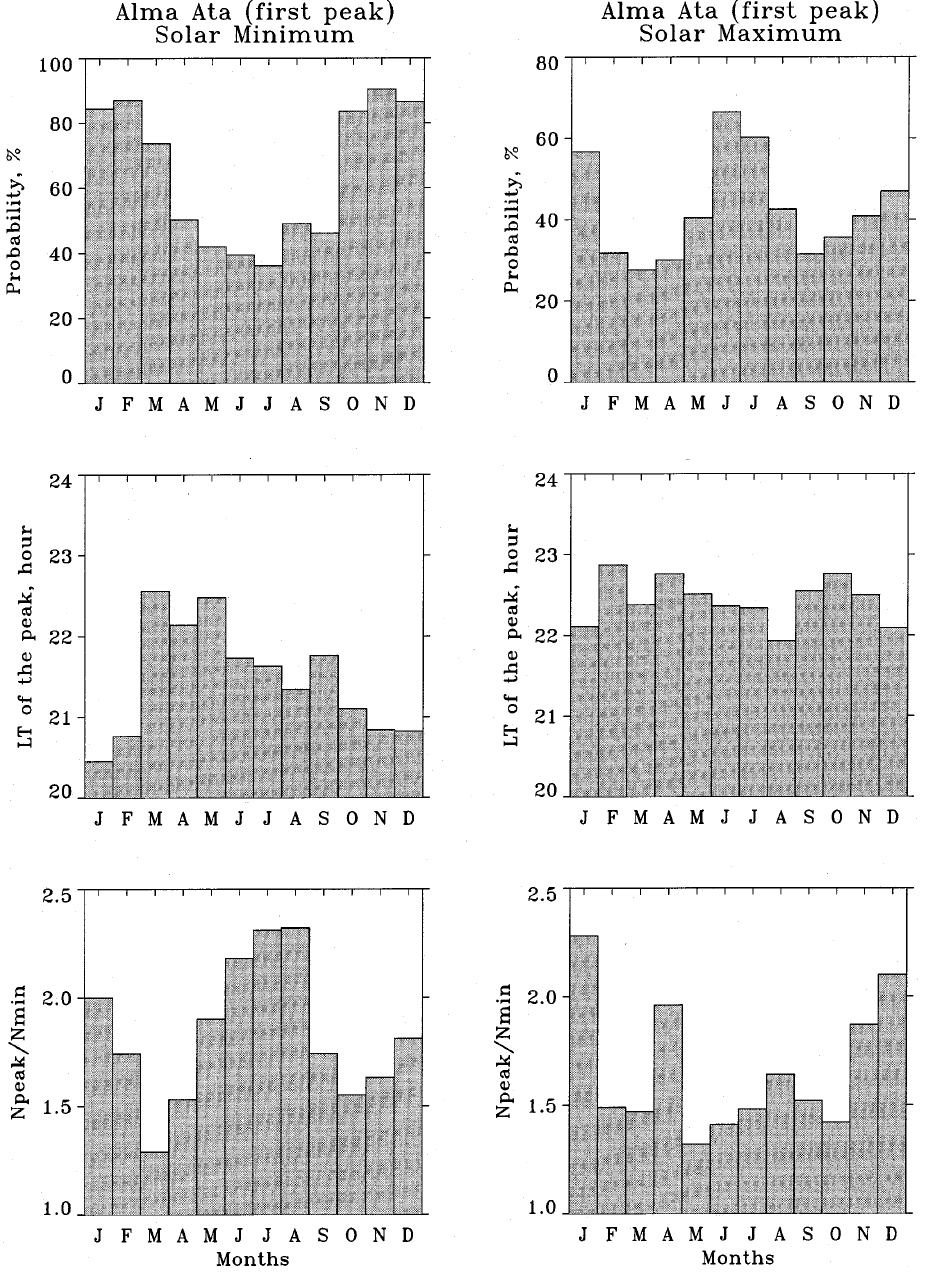
Fig. 2. Seasonal variations of occurrence probability ( top ), timing ( middle ), and amplitude ( bottom ) of the 1st peak at Alma-Ata at solar minimum ( left-hand side ) and solar maximum ( right-hand